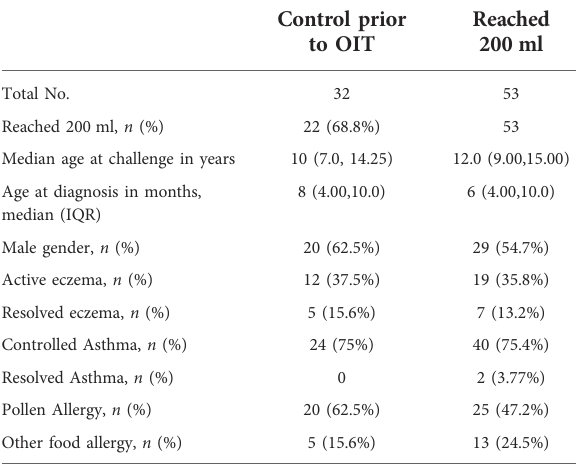
TABLE 1 Demographic data among children undergoing OIT.